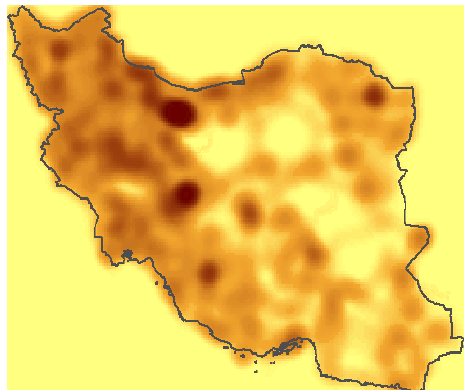
Figure 7. Transportation development index map in Iran